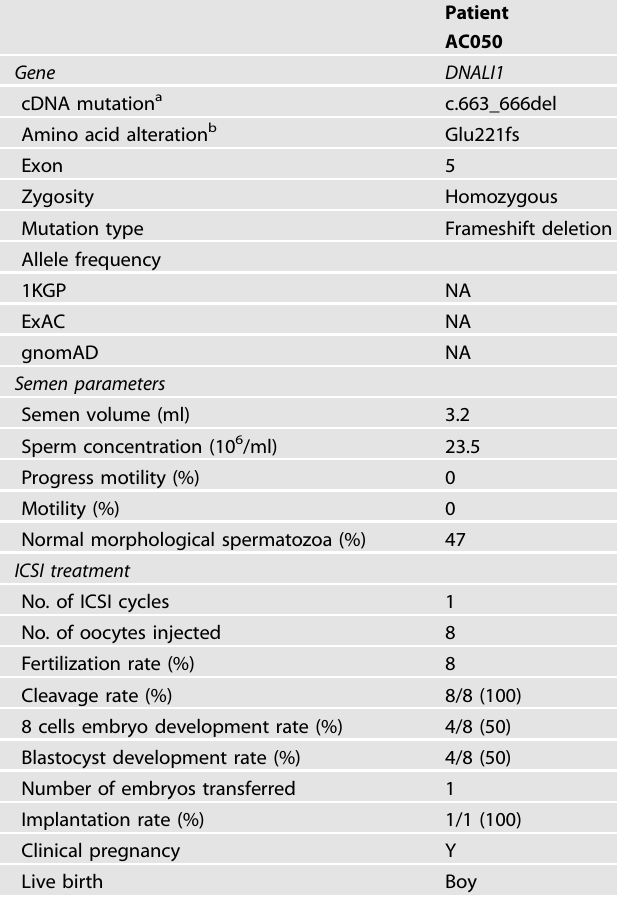
Fig. 1 The DNALI1 loss leads to the asymmetrical development of sperm fi brous sheaths in humans. A Pedigree analysis of the family affected by bi-allelic DNALI1 mutations, as identi fi ed by WES. The black- fi lled squares represent the infertile males of this family. B The WES- identi fi ed mutations are further con fi rmed via Sanger sequencing. The black box marks the missing sequence. C DNALI1 is missing in spermatozoa from the patient. D Spermatozoa from a fertile control male and the DNALI1 663_666del patient are stained with anti-DNALI1 and anti- β TUBULIN ( β -TUB). E Light microscopy revealed spermatozoa with normal morphology from the DNALI1 663_666del patient and a control male. F TEM images of the fl agellar cross-sectional structure of a control human and patient. The red arrow represents an obvious IDA. The numbers highlight the quantity of peripheral microtubules. A yellow dash represents the LCs, which are diagonally positioned in the control spermatozoa. G TEM cross-sections of the principal piece of sperm are quanti fi ed and categorized according to the LC symmetry. H and I Immuno fl uorescence (IF) staining against AKAP4 and GAPDHS. The asterisk indicates a signi fi cant decrease in AKAP4 protein expression.